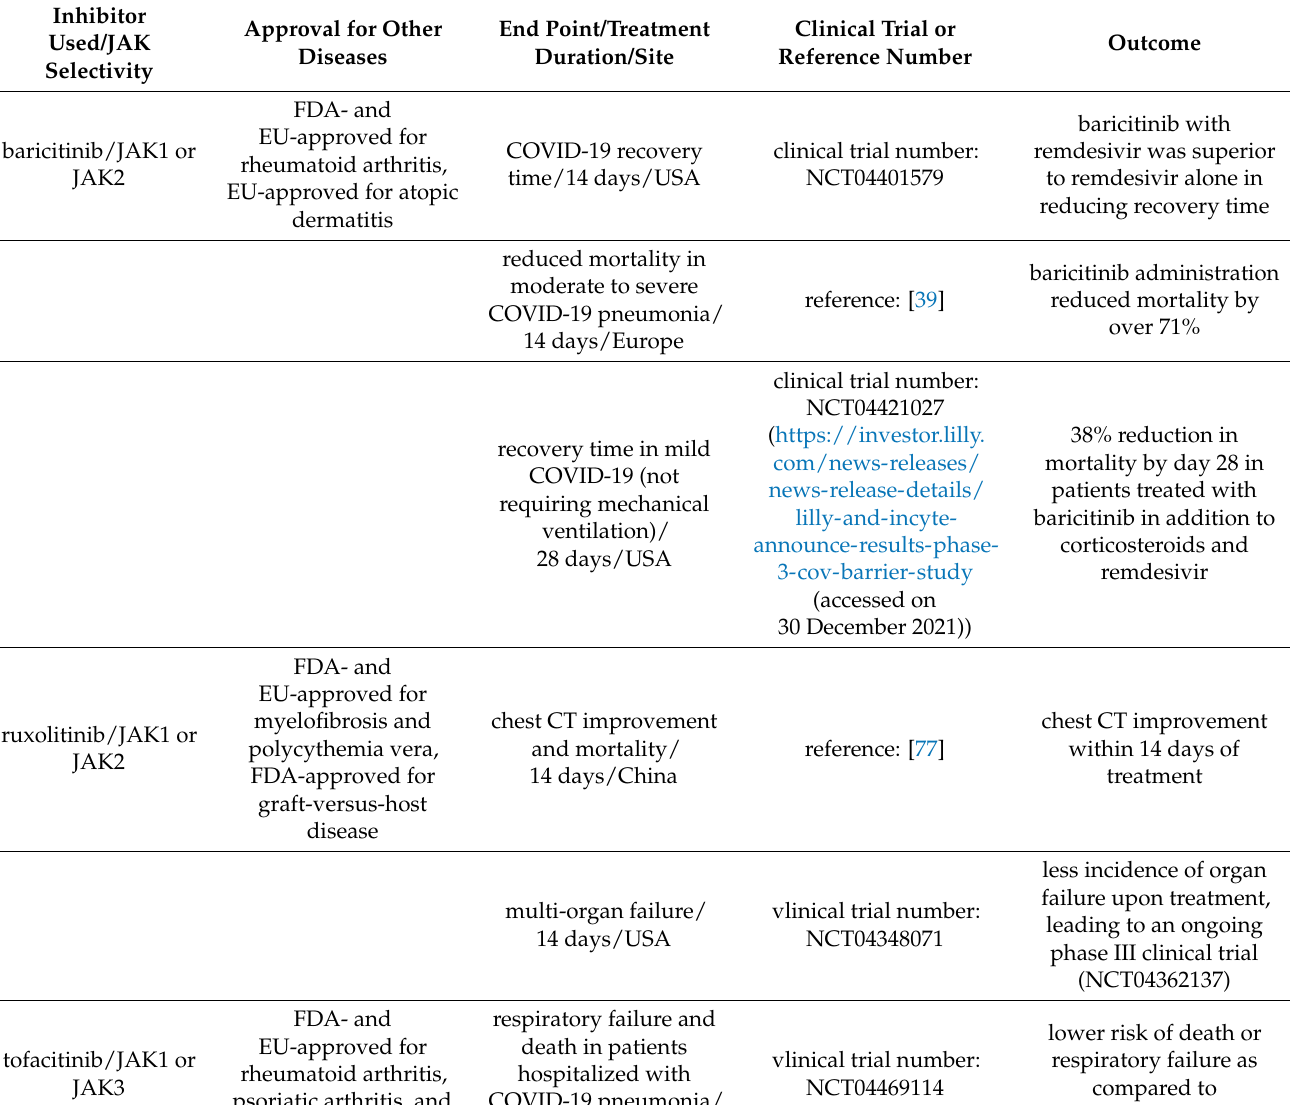
Table 1. JAK–STAT inhibitors in the treatment of